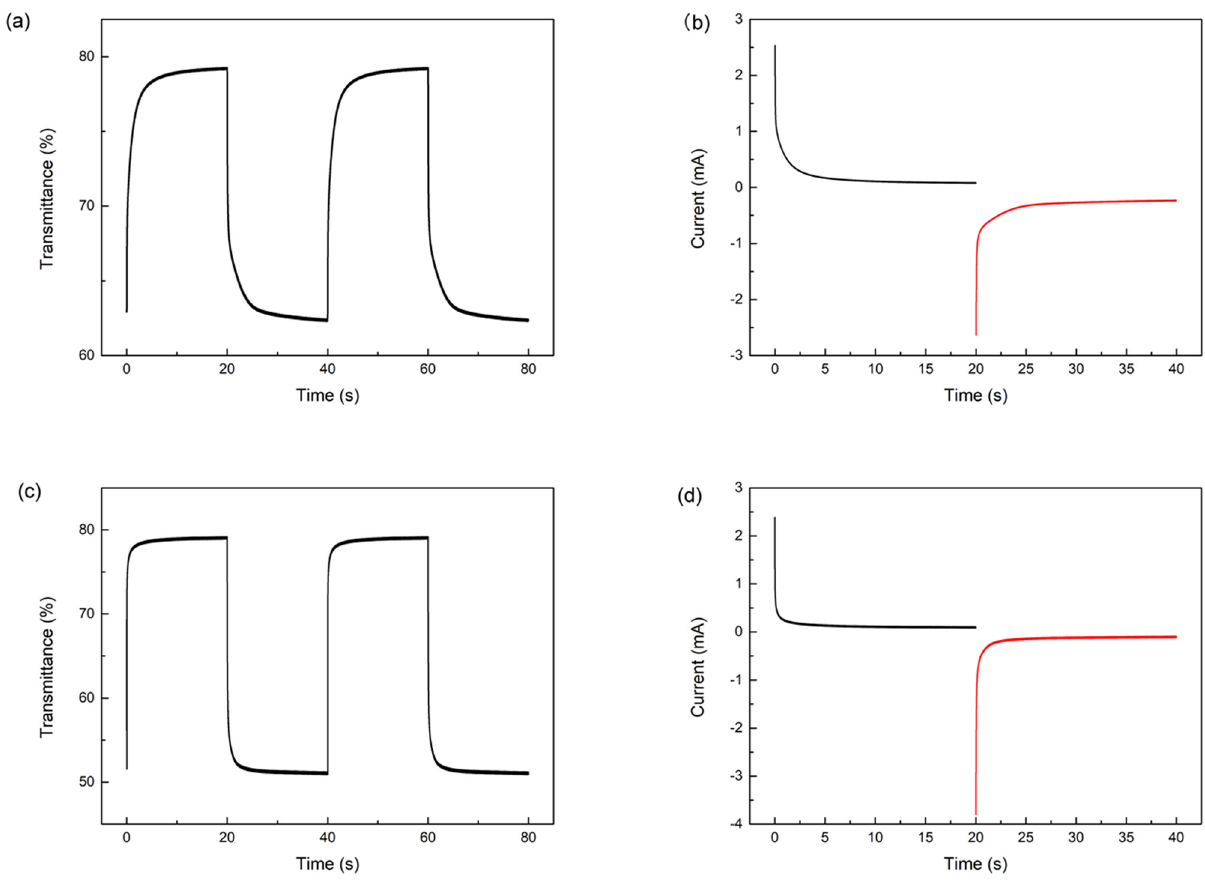
Figure 6: ( a ) The timing transmittance curves of P ( TTF - Th ) ; ( b ) the timing current curve of P ( TTF - Th ) ; ( c ) the timing transmittance curves of P ( DTTF - Th ) ; and ( d ) the timing current curve of P ( DTTF - Th ) .